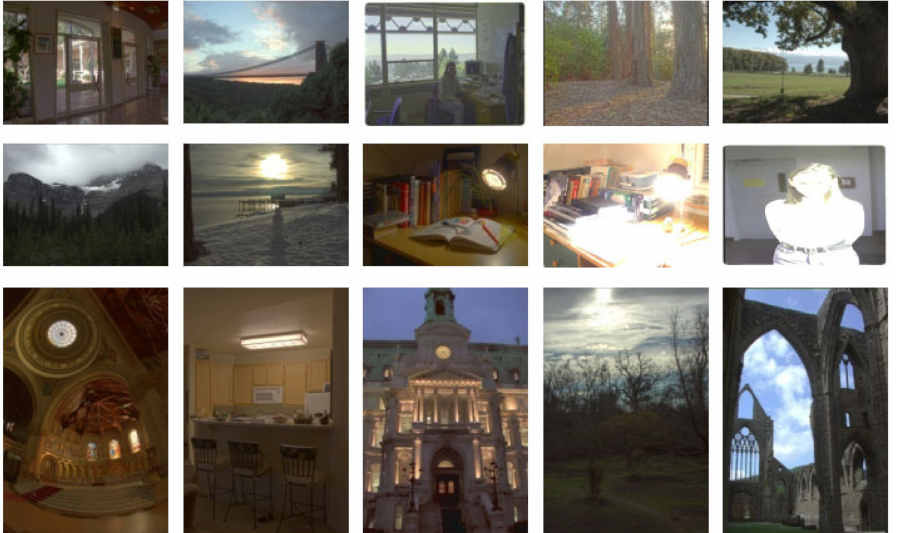
Figure 10. The 15 radiance maps from the TMQI